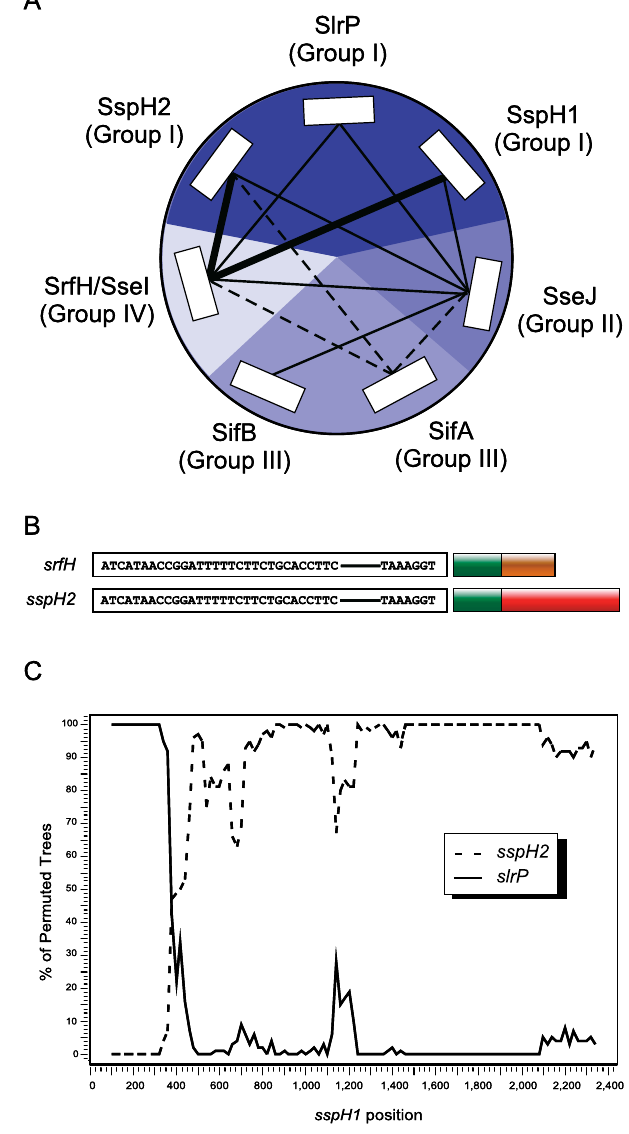
Figure 3. Terminal Reassortment among Effectors in Salmonella enterica (A) N-terminal homology among seven effectors of S. enterica represent- ing four distinct homology groups. Each homology group has been encapsulated in a shade of blue and contains proteins that share full- length homology. The interconnecting lines indicate the degree of N- terminal relatedness, with dashed lines indicating , 40% similarity, thin, solid lines 40%–60% similarity, and thick, solid lines . 60% similarity. (B) S. enterica effectors sspH2 and srfH share a highly conserved upstream region, ssrAB promoter box, and N-terminal region, while the C terminus of these proteins is non-homologous. (C) Bootscan of the homologous S. enterica effectors sspH1, sspH2, slrP, and N-terminal homolog sseI/srfH to detect recombination, with the nucleotide sequence of sspH1 as the query sequence. sseI / srfH had , 35% permuted trees and was omitted from the figure. Bootscanning was performed with Simplot v 3.5.1 using neighbor joining with the F84 model, gapstrip off, and window and step sizes of 200 and 20, respectively. Other members of this effector family were excluded to facilitate optimal nucleotide alignment. DOI: 10.1371/journal.ppat.0020104.g003 PLoS Pathogens |